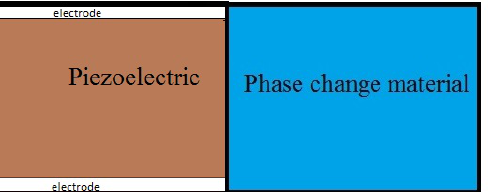
Figure 2. Geometry of the BAW resonator assisted by PCM box in 2D